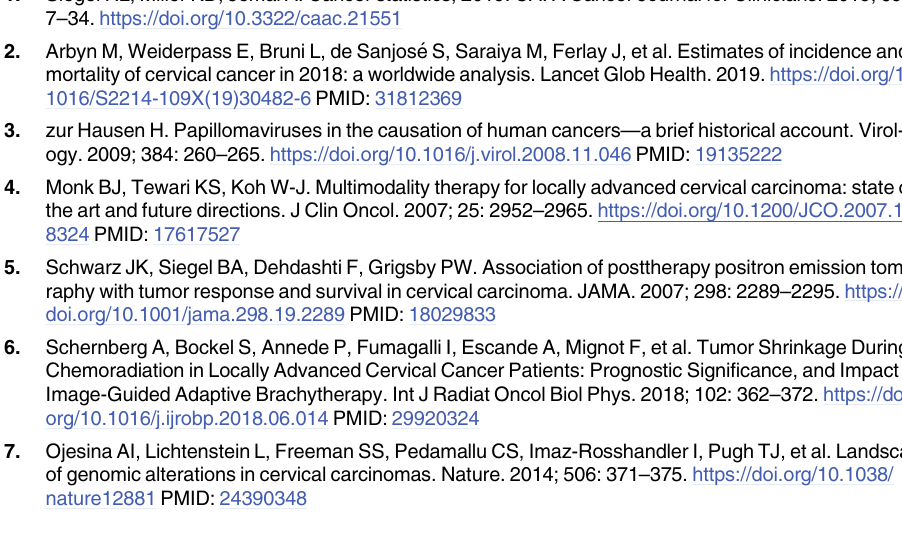
S2 Fig. Lollipop plots showing mutation site, type, and frequency of canonical genes associ- ated with cervical cancer pathogenesis for all